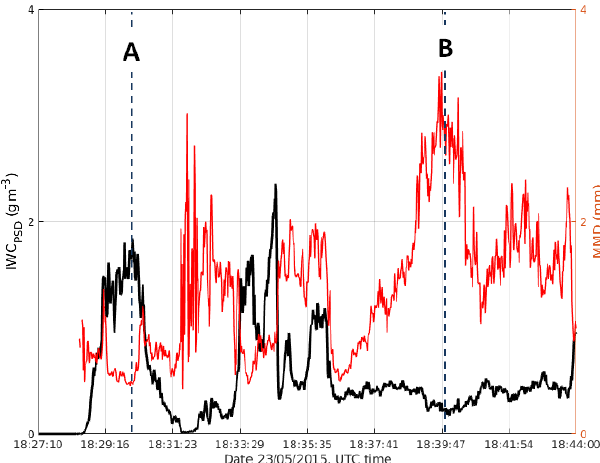
Figure 10. IWC PSD and MMD time series for the 23 May case.